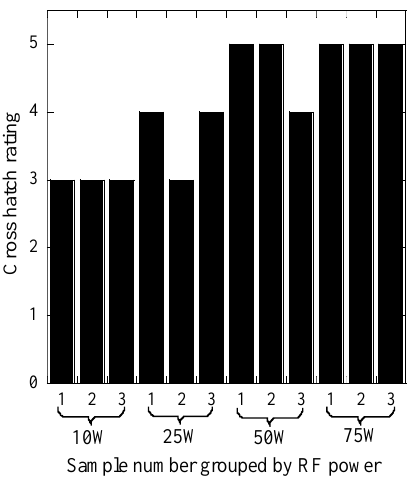
Figure 8. Adhesion data for pp–GT thin films at 10, 25, 50, and 75